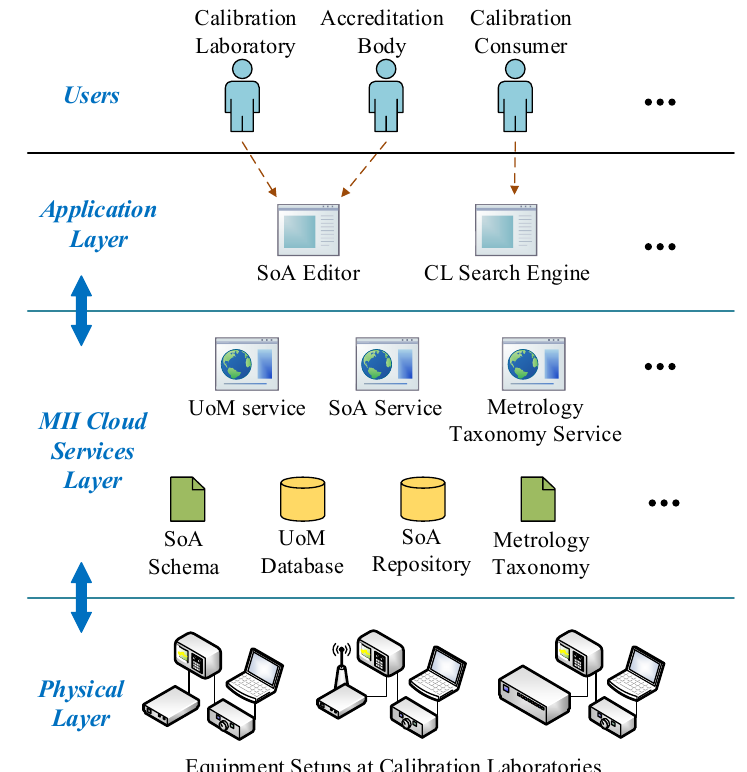
Figure 4. The SoA editor and the IoMT